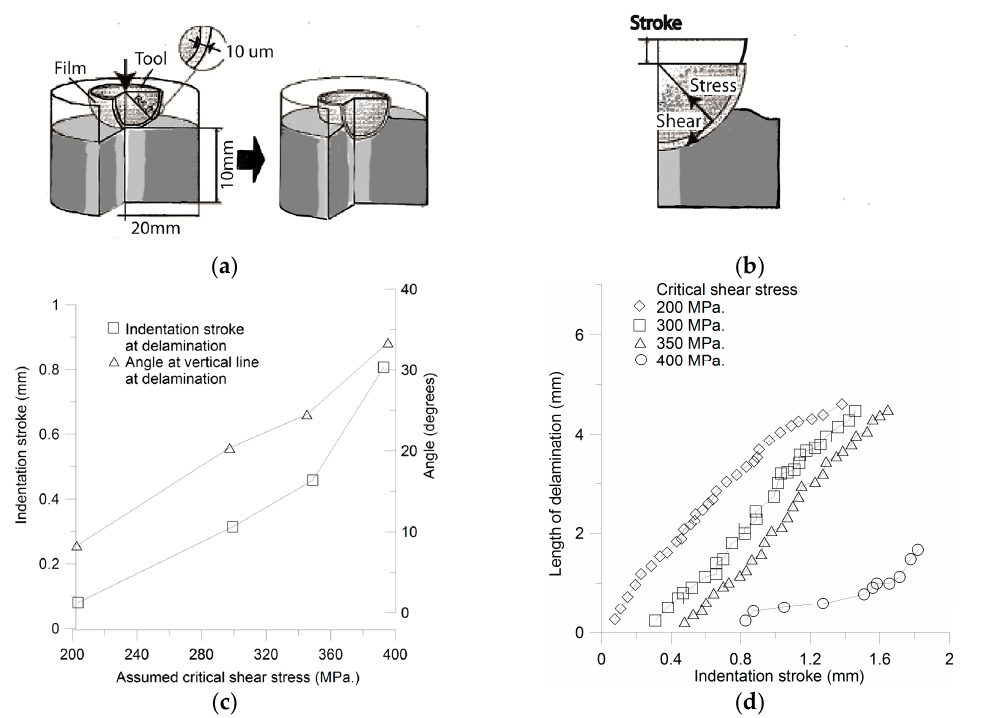
Figure 17. Illustration of layer adhesion testing, ( a ) Testing model; ( b ) stresses in the interface, after ref. [42] ( c ). Illustration of layer adhesion testing, Relation between initial delamination and assumed critical shear stress; ( d ) relation between length of delamination and indentation after ref. [42].